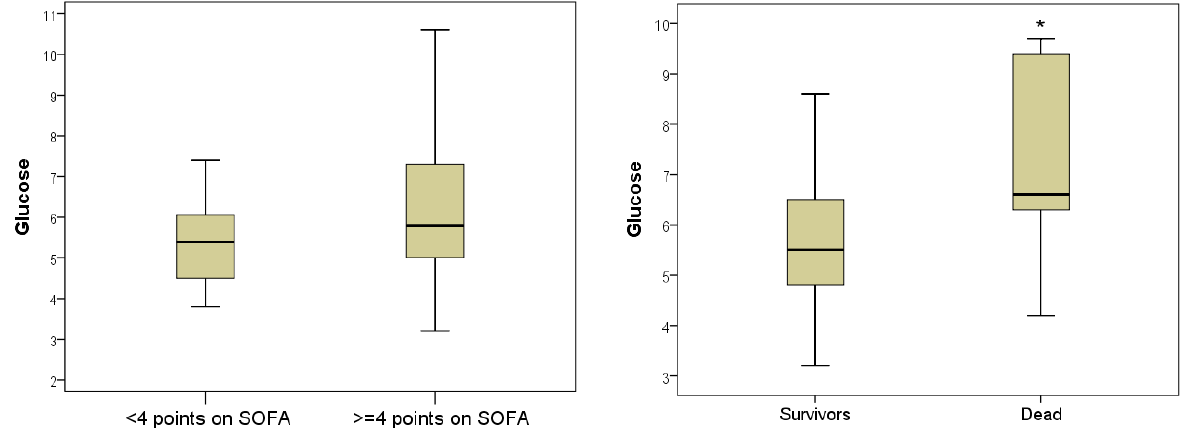
Figure 7. Blood glucose index during hospitalization in severe and non-severe patients and in patients with favorable and unfavorable hospital outcome (*—the difference between the two groups according to the Mann – Whitney criterion at p < 0.05).